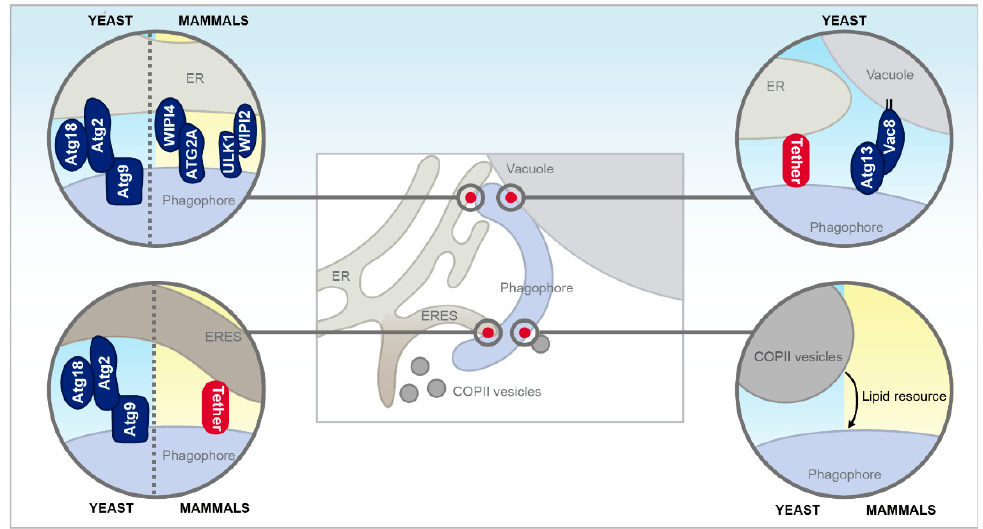
Figure 4. Membrane contact sites and functional interorganellar interaction with the growing phagophore in yeast and mammals. Besides direct membrane contacts sites between the vacuole, the endoplasmic reticulum (ER) and the phagophore, COPII vesicular transport between the ER exit sites (ERES), and the phagophore mediate autophagosome formation and elongation. Please see main text for further details.